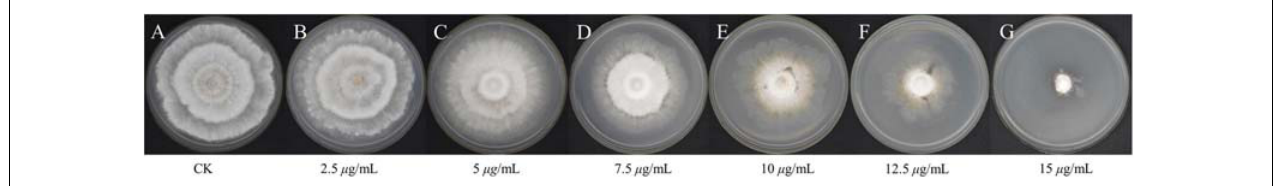
FIGURE 1 | Mycelial growth of Ps. camelliae-sinensis strain GZHS-2017-010 treated with different concentrations of phenazine-1-carboxylic acid (PCA). (A) CK; (B) 2.5 µ g/mL; (C) 5 µ g/mL; (D) 7.5 µ g/mL; (E) 10 µ g/mL; (F) 12.5 µ g/mL; (G) 15 µ g/mL.